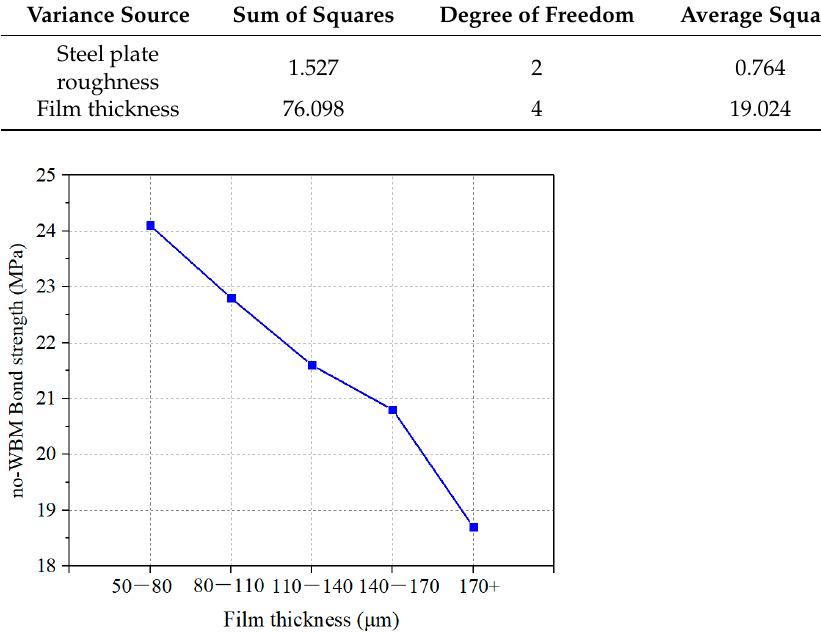
Table 13. Primer surface conditions of the no-WBM specimens. Figure 14. Relationship between the primer thickness and bond strength. Figure 14. Relationship between the primer thickness and bond strength.